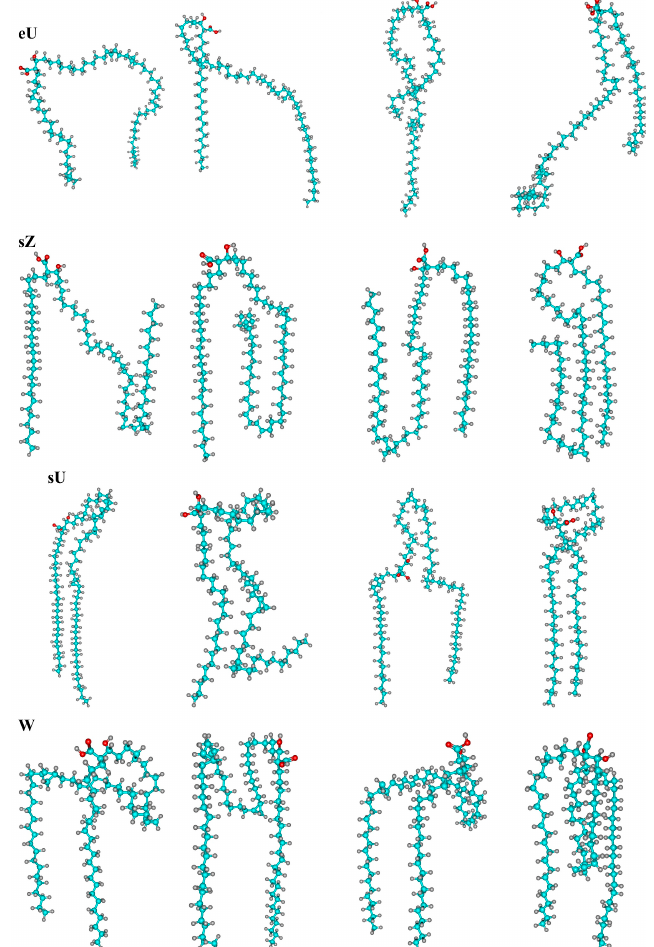
Figure 2. Typical structures of the most abundant conformation classes eU, sZ, sU, and W formed in the single-component AMA-W membrane during 300 ns